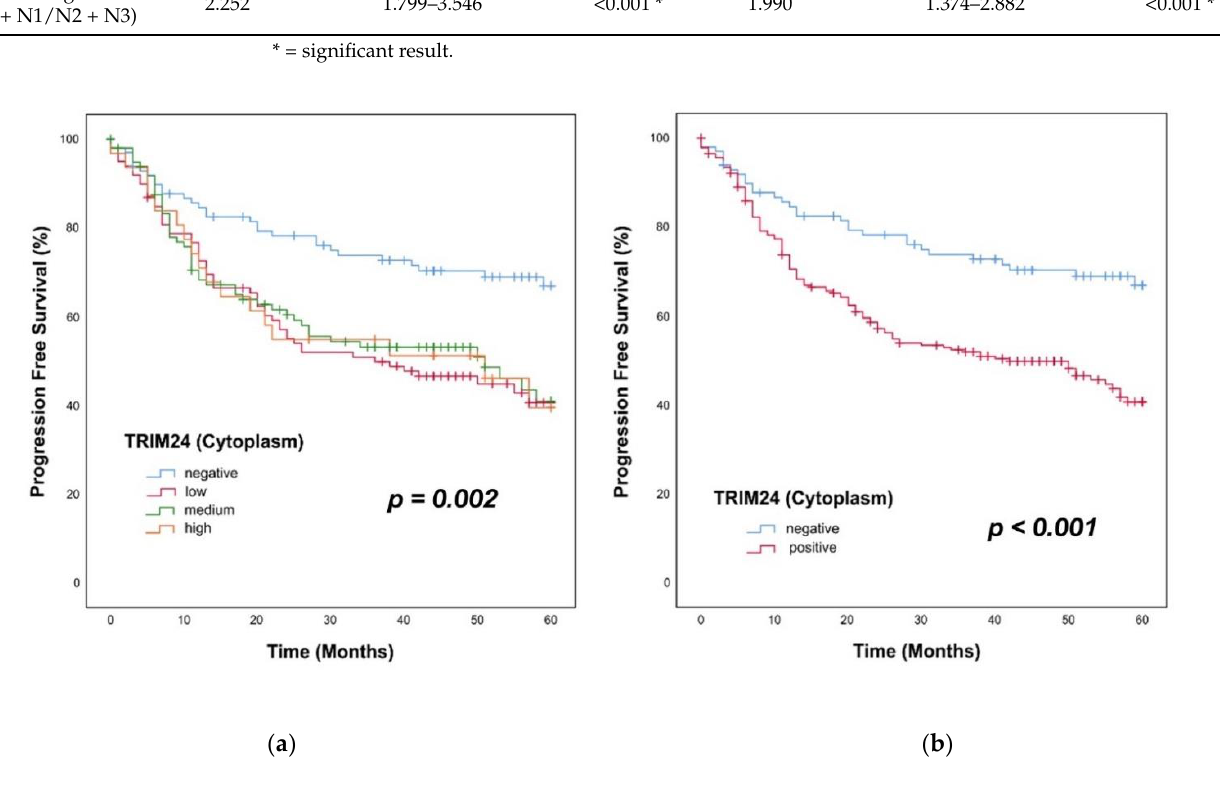
Figure 6. Kaplan–Meier analyses of TRIM24 expressing HNSCC PTs. ( a ) We could show a significant difference in the PFS rates over 60 months of patients with TRIM24 negative, low, medium, and high expressing PTs (log–rank test, p = 0.002). ( b ) We compared all TRIM24 expressing PTs against the TRIM24 − tumors. The patients with TRIM24+ PTs show a significantly worse PFS over 60 months than patients with TRIM24 − PTs (log–rank test, p < 0.001). Table 2. Univariate and multivariate cox regression for 60-months PFS.